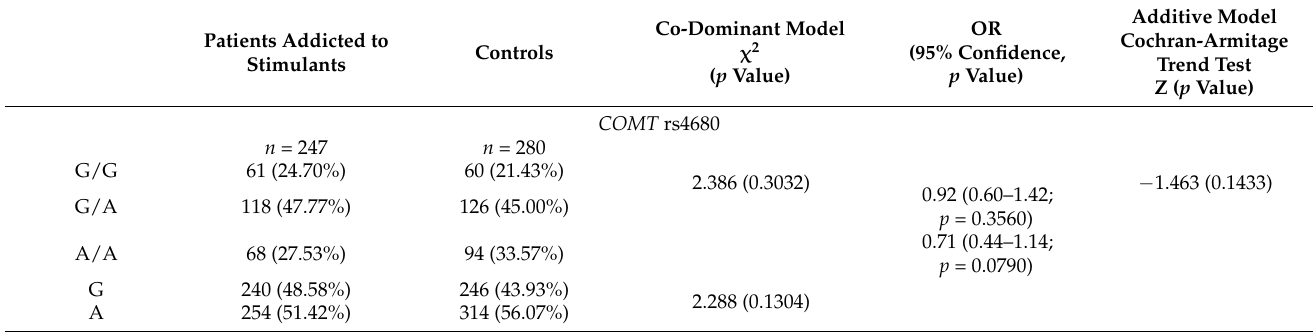
Table 3. Frequency of genotypes and alleles of COMT rs4680 in the group of patients addicted to stimulants and controls.